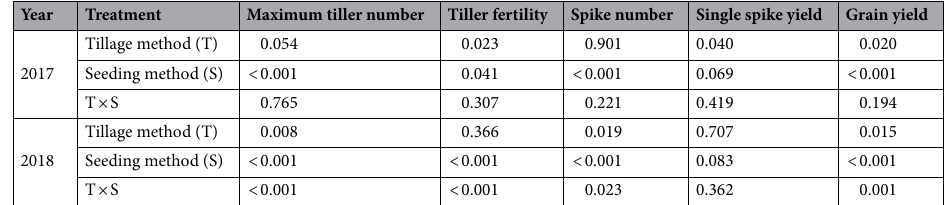
Table 2. Analysis of variance (ANOVA) p -values for the effects of tillage method, seeding method, and their interaction (T × S), on the maximum tiller number, tiller fertility, grain yield, and yield components in 2017 and 2018.